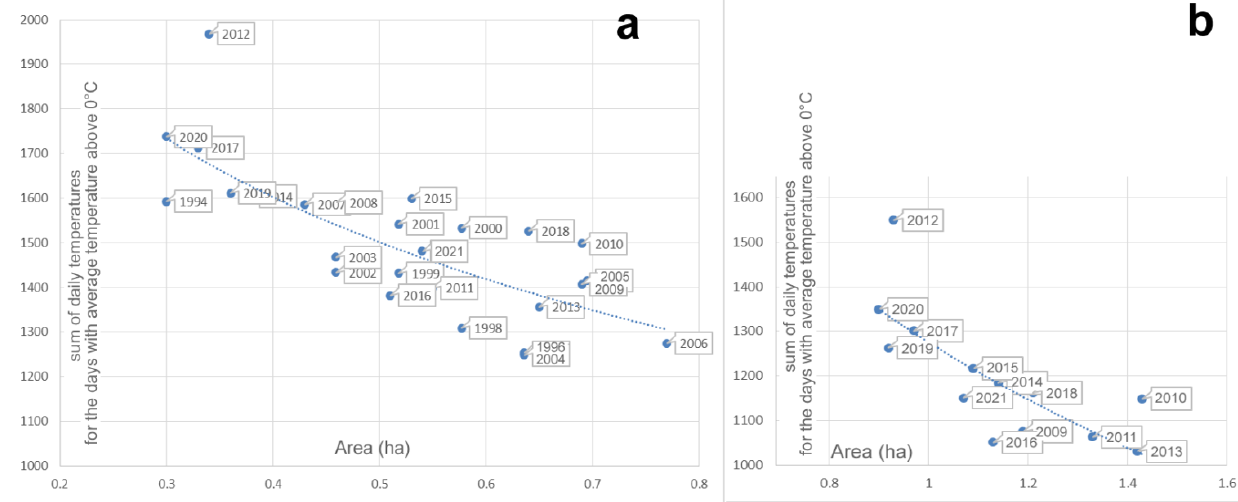
Figure 8. Graphical representation of the relationship between the area of Snezhnika glacieret and the sum of daily temperatures for the days with average temperature above 0 °C (sum of positive daily temperatures) at 2450 m a.s.l. ( a ), and between the area of Banski suhodol glacieret and the sum of positive daily temperatures at 2650 m a.s.l. ( b ). Sums are derived by extrapolation from data from Musala peak for the years 1994–2021 ( a ) and 2009–2021 ( b ) [22]. Table 4. Coefficient D illustrating the graphical deviation of points on Figures 7 and 8 from the dependency trendlines, and differences in D between consecutive years.